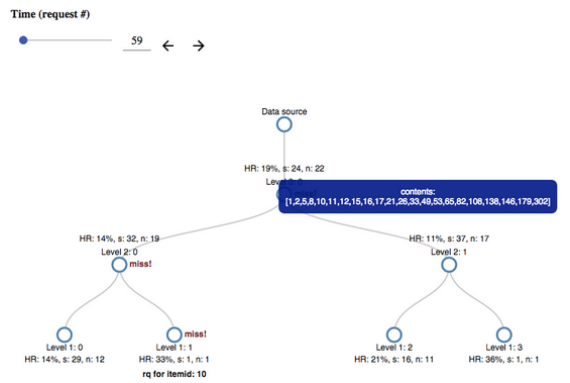
Figure 1: Inspection of a caching